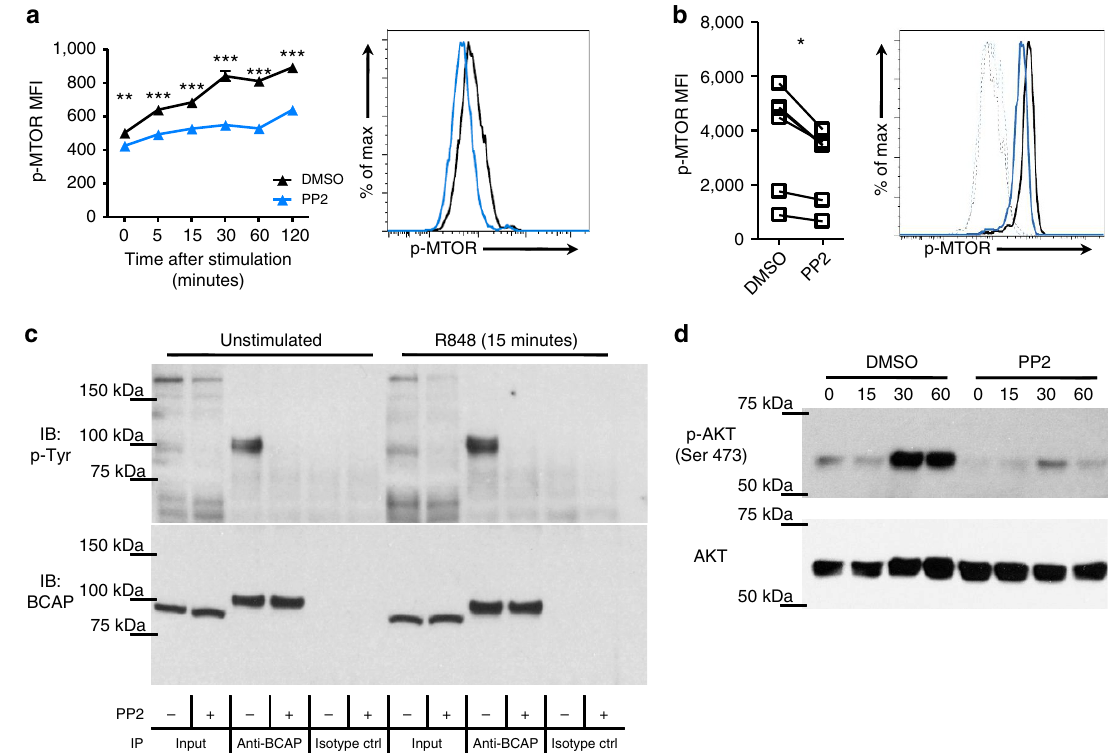
Figure 6 | SFKs are necessary for mTOR and BCAP phosphorylation in human pDCs. ( a ) CAL-1 cells were pre-treated for 1h with PP2 (10 m M; blue) or DMSO control (black) before stimulation with R848 for the indicated time periods (minutes). p-MTOR was determined by flow cytometry. Histograms depict the 15min time point. ( b ) Human PBMCs were pre-treated as in a and stimulated for 15min with R848. p-MTOR was determined by flow cytometry in gated pDCs. Lines in graph connect the same donor and the histogram depicts a representative donor; dotted lines, unstimulated; solid lines, R848 stimulation. ( c ) CAL-1 cells were pre-treated as in a and then stimulated with R848 for 15min. Protein immunoprecipitation was performed using anti-BCAP antibody or isotype control antibody and levels of tyrosine phosphorylation (p-Tyr) and BCAP were assessed by immunoblot. ( d ) CAL-1 cells were pre-treated as in a and then stimulated with R848 for the indicated time periods (minutes). p-AKT Ser473 and AKT levels were determined by immunoblot. Data are representative of two ( d ) or three ( a , c ) independent experiments or five donors processed separately ( b ). Graphs depict mean ± s.d. of replicates within one representative experiment ( a , c , d ) or individual donors ( b ). Two-way ANOVA ( a ) and two-ways Student’s t -test ( b ) were used